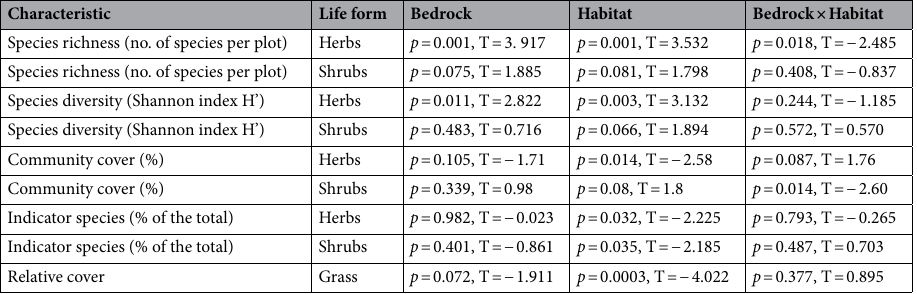
Table 2. Summary table of the differences in species richness, diversity, cover, and representation of indicator species recorded in the study plots by habitat and bedrock, with results of statistical tests. DF res = 18 for bedrock, DF res = 36 for Habitat, and Bedrock × Habitat